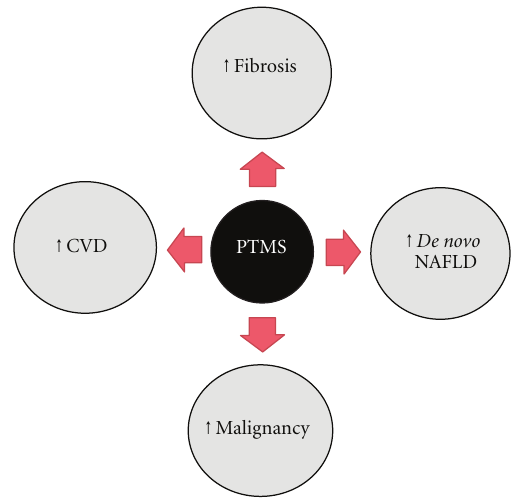
Figure 1: Complications of Posttransplant Metabolic Syndrome (PTMS). CVD = cardiovascular disease, NAFLD = nonalcoholic fatty liver